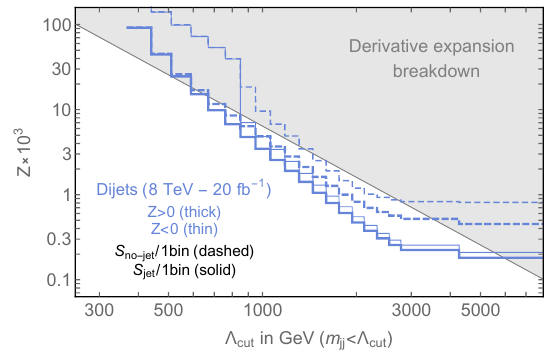
Figure 7 . (cid:3) cut plot for the 8 TeV dijet projection. We use only the central rapidity bin, y (cid:3) < 0 : 5, to extract the limit. We show the di(cid:11)erent behavior between PDF sets S no-jet and S jet . Fitting the (cid:12)rst two rapidity bins of the dijet distribution yields quantitatively similar results to the S jet curve. 95% CL limits are shown for both Z > 0 (constructive interference with the SM) and Z < 0 (destructive interference with the SM).